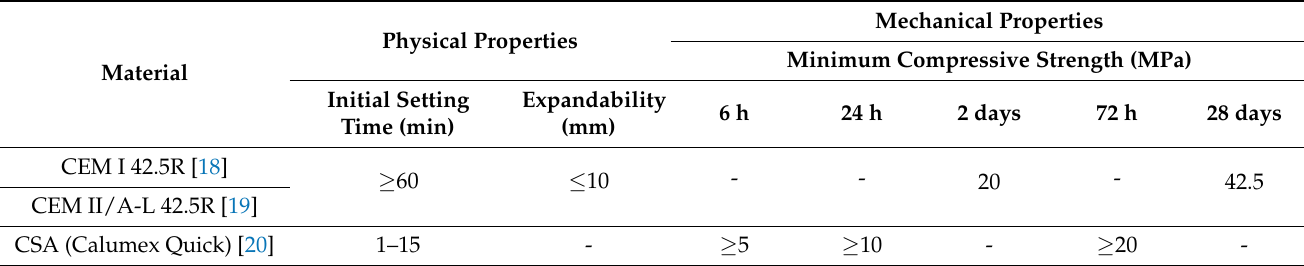
Table 2. Physical and mechanical properties of Portland cement and CSA